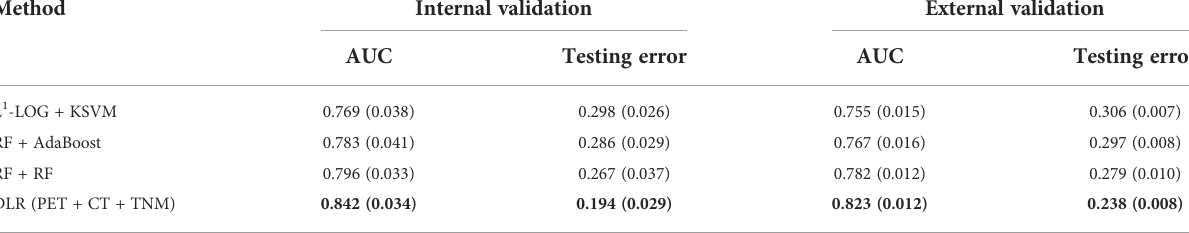
The average results are reported with standard deviation in parentheses. The best result in each column is in bold. DLR, deep learning-based radiomics; AUC, area under the receiver operating characteristic curve; L 1 -LOG, L1-Logistic Regression; KSVM, Kernel Support Vector Machines; RF, Random Forest.